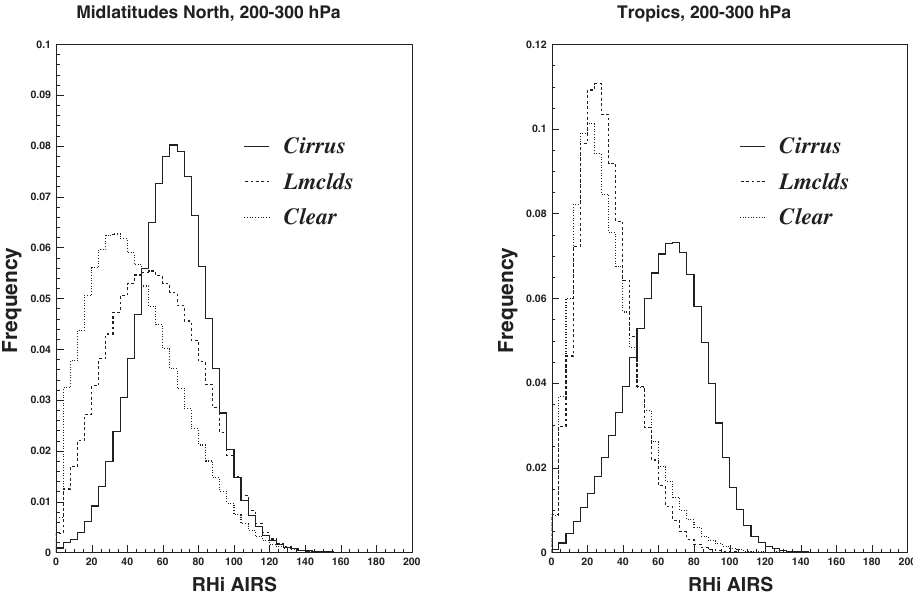
Fig. 3. Distributions of AIRS relative humidity RHi A for three classes of AIRS cloud properties in two latitude bands: Northern Hemisphere midlatitudes (40–60 ◦ , left) and tropics (20 ◦ N–20 ◦ S, right). For lmclds and clear situations RHi A is all measurements in pressure layers 200–250 and 250–300hPa. For cirrus situations RHi A is restricted to one of these two pressure layers enclosing the cloud pressure p cld .